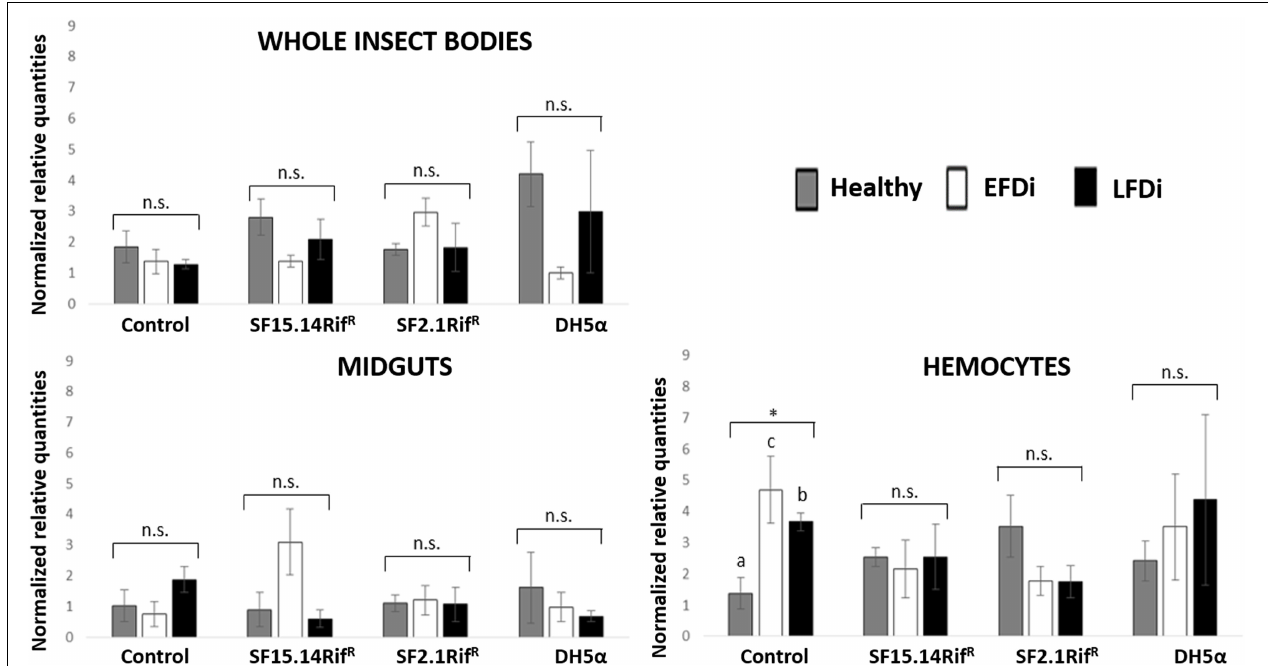
FIGURE 8 | Temporal trend of gene expression for phenoxidase gene. Normalized relative quantities are displayed for whole insect bodies, midgut sections, and cultured hemocytes of insects treated with Asaia SF15.14Rif R , Asaia SF2.1Rif R , and E. coli DH5 α pKan(DsRed), along with the control. Healthy: time 0 of FDp infection; EFDi time 0 + 5 days of FDp infection; LFDi: time 0 + 21 days of FDp infection. Asterisk shows significant difference according to ANOVA ( P < 0.05); different letters indicate significantly different values according to Tukey’s test (a < b). DH5 α : E. coli DH5 α pKan(DsRed); n.s., not